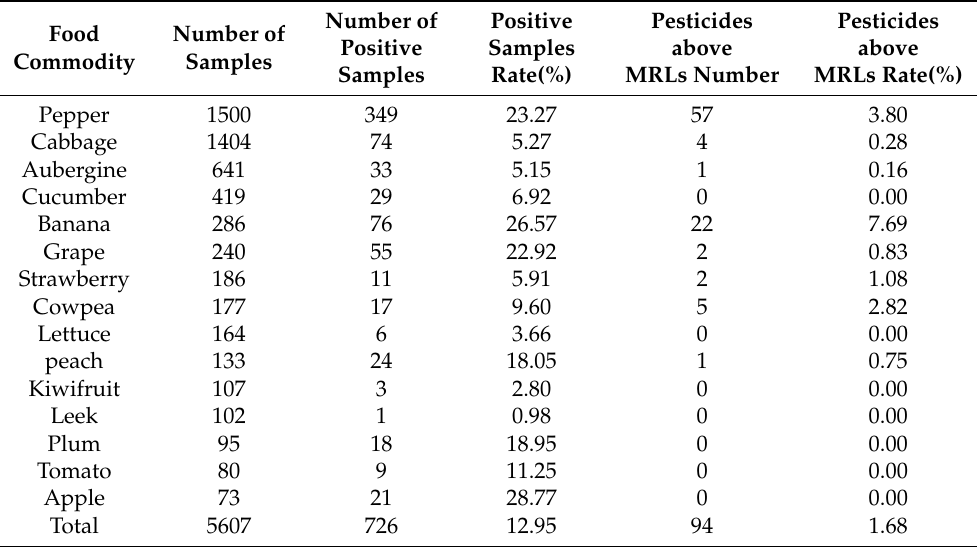
Table 4. Monitoring of different pesticide residues in food